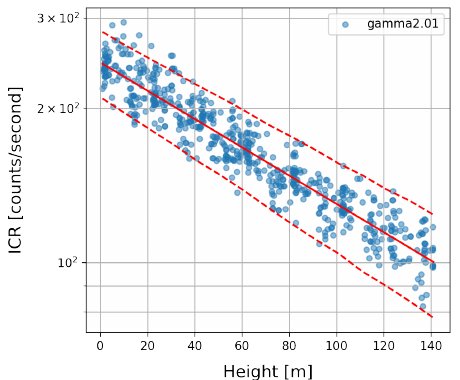
Figure 3. Radiation background modeling. The measured counts per second are plotted at their corresponding measuring